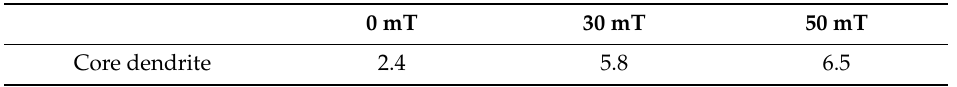
Table 8. EDS measurement of Nb in the core dendrite of the samples fabricated with di ff erent electromagnetic field intensities (wt.%).